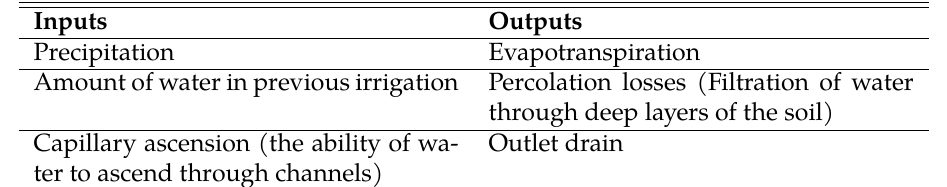
Table 2: Factors related to water